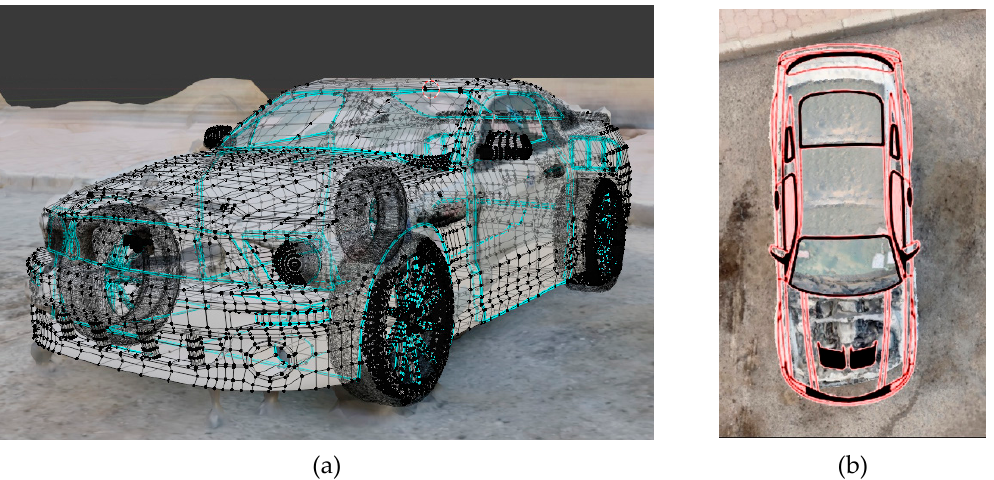
Figure 11. Damage profiles of the vehicle defined in terms of ( a ) 3D mesh vertices from front-left view ( b ) 3D mesh edges from a top view to assess the damage and deformation of the vehicle’s body.